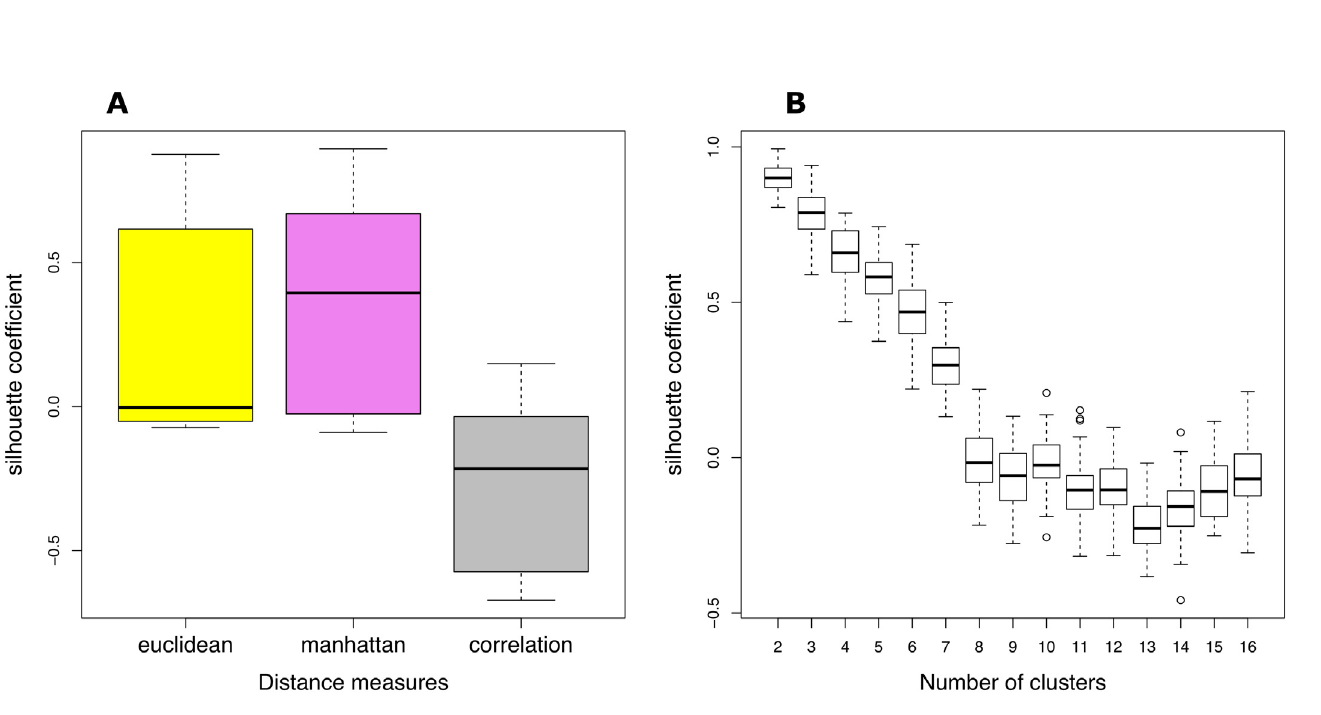
Fig 14. Silhouette coefficient distributions for fuzzy c-means method. Silhouette coefficient distributions computed for different distance measures (Panel A), and for different number of clusters (Panel B) only for the chosen metric Manhattan.